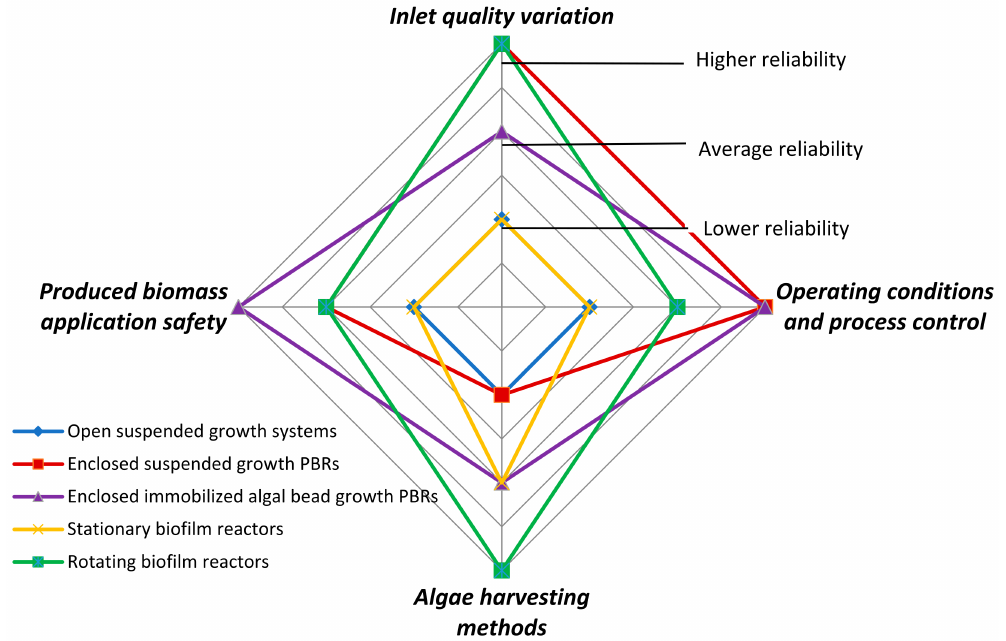
Figure 12. Overview of the four analyzed aspects of the reliability of the compared systems for secondary treated